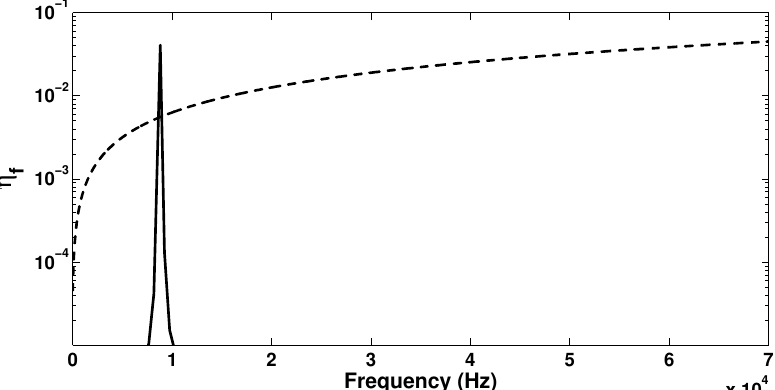
Figure 6. The frequency-dependent loss factor for the flexural wave propagating within the laminate with: a shunted piezoelectric patch (–) and with a viscous damping of C = 10 − 7 K (- -). qq qq